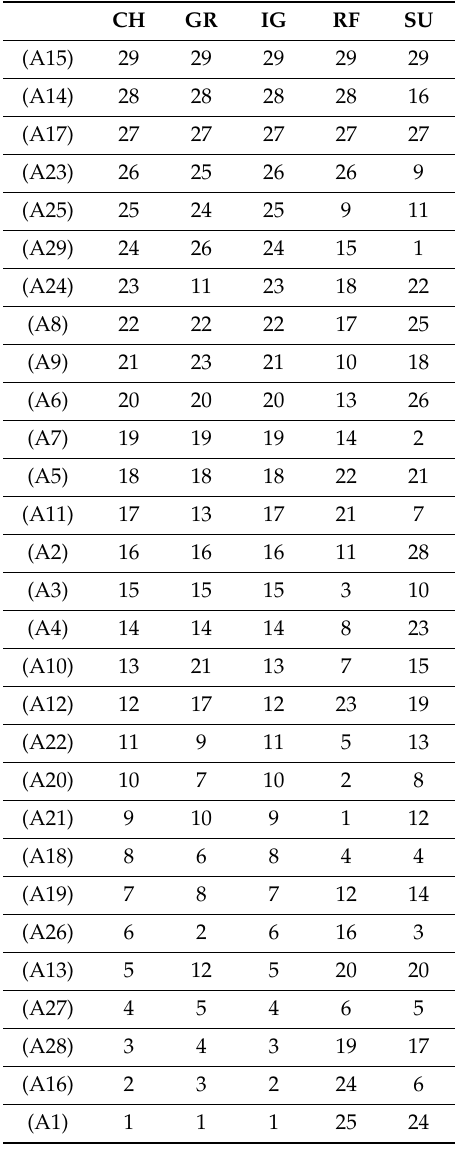
Table 5. Results of the five ranking methods (bigger number mark highest